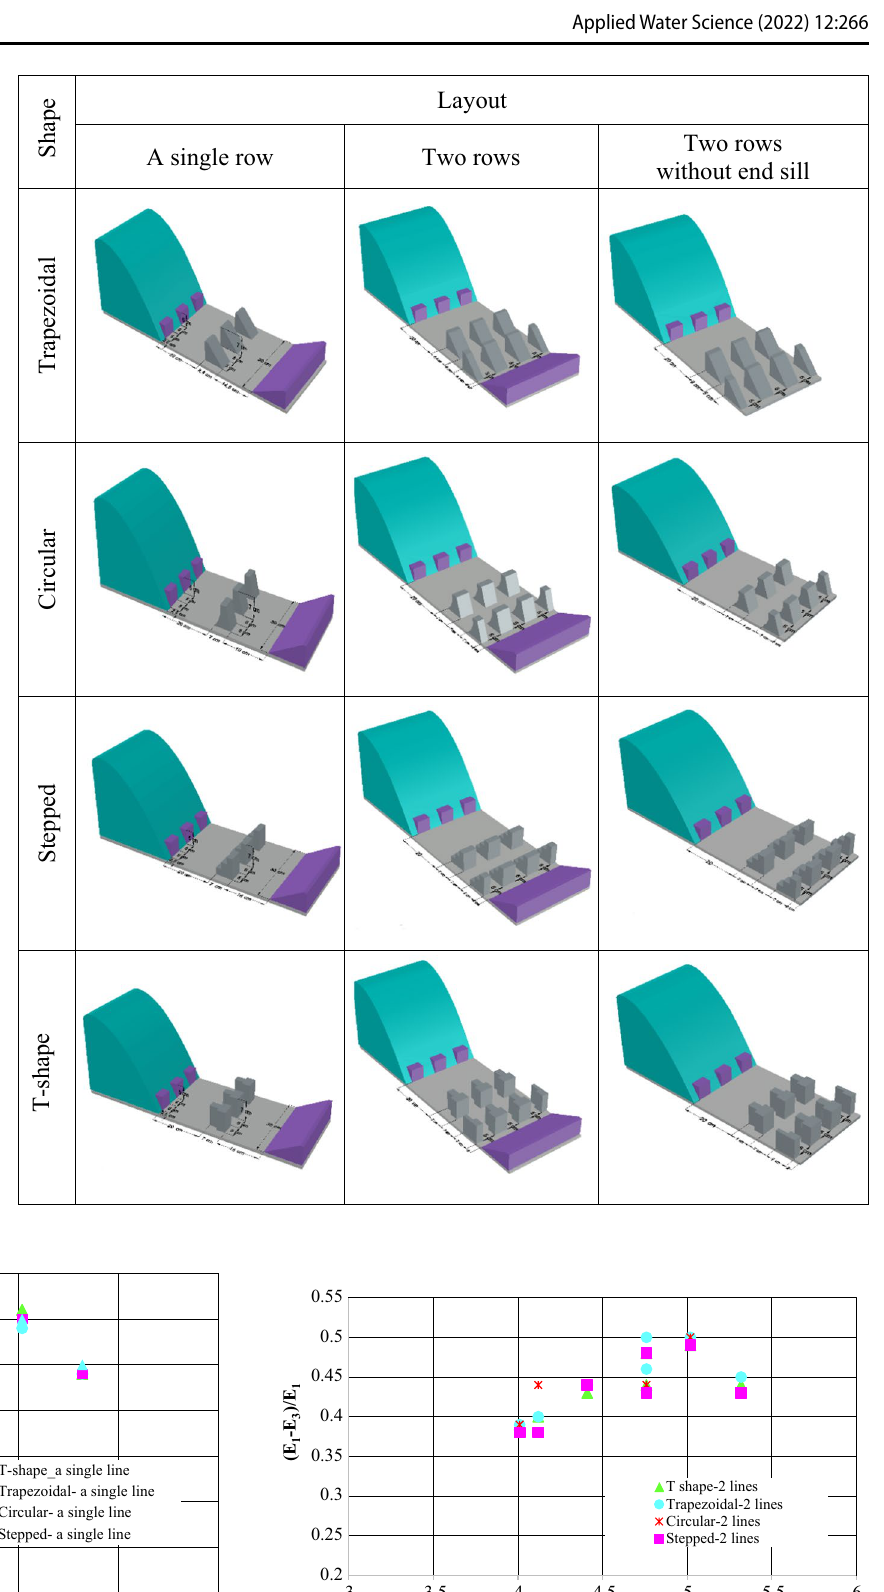
Table 2 Solid models used in the CFD simulations